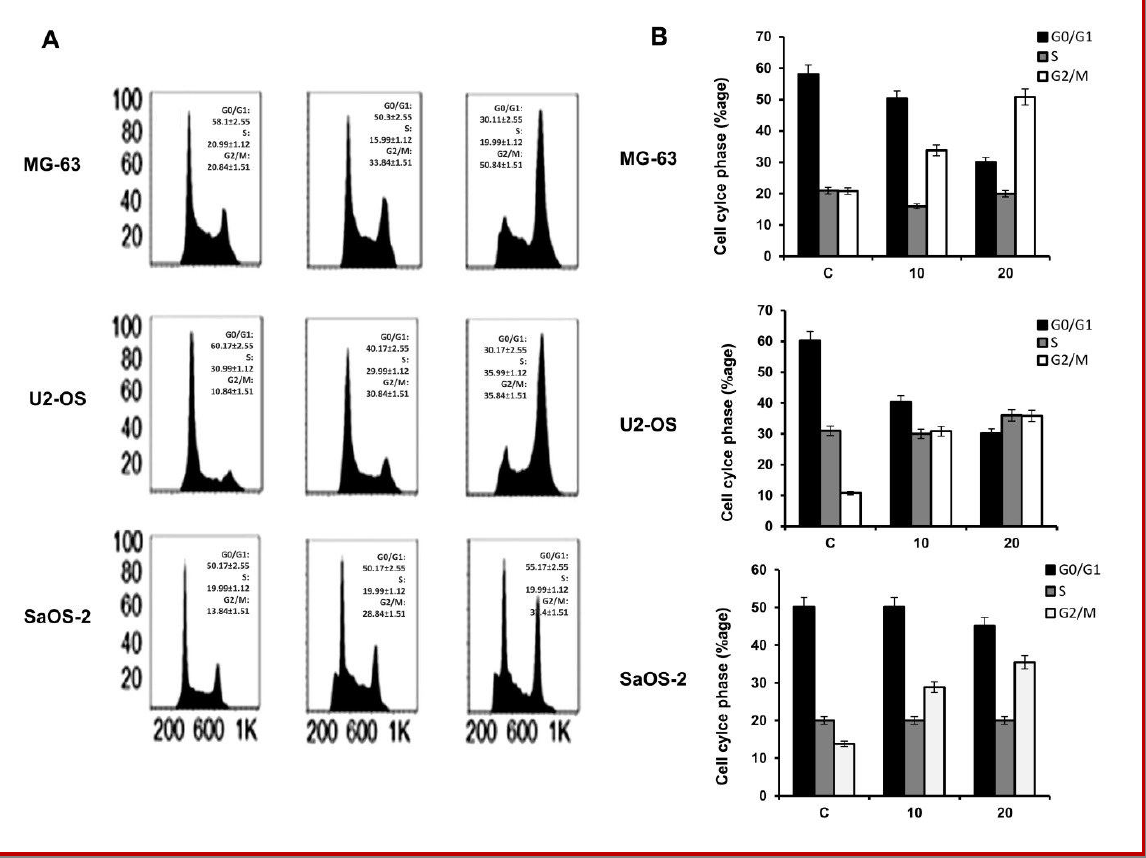
Figure 2: Withaferin A- induced G2 ⁄M phase arrest in osteosarcoma cells was measured with cell cycle distribution by flow cytom- etry analysis C, control; 10, 20 µM withaferin A. U2OS, SaOS-2 and MG-63 cells were treated with 10 and 20 µM withaferin A for 48 hours (control: cells treated withdimethylsulfoxide). Treatment with withaferin A resulted in an increase in the number of cells in the G2 ⁄M phase and a d ecrease in the number of cells in the G0⁄G1 phase, indicating a withaferin A - induced G2⁄M phase arrest. Results are plotted as the percentage of cells in each cell cycle phase. Data are presented as mean ± SD of three independent